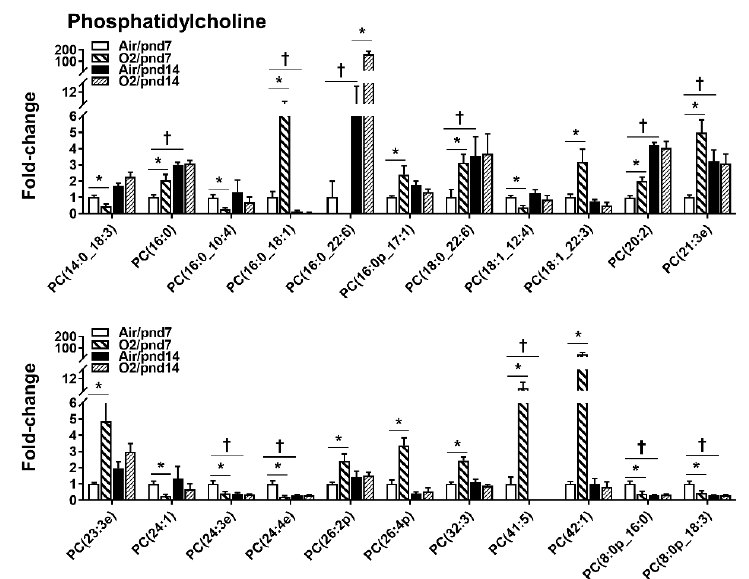
Figure 3. Compositional changes of lung PC species in mice exposed to hyperoxia as neonates. PC species in mouse lungs with 2-fold change and p < 0.05 between air and hyperoxia groups at pnd7 and pnd14 were listed. n = 6. * p < 0.05 vs. corresponding air; † p < 0.05 vs. air/pnd7 .